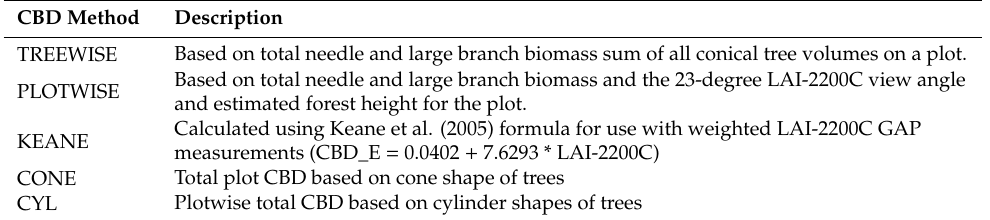
Table 1. Names and descriptions of the five calculation methods evaluated in the development of the canopy bulk density (CBD) model. Units for all CBD measurements are in kg / m 3